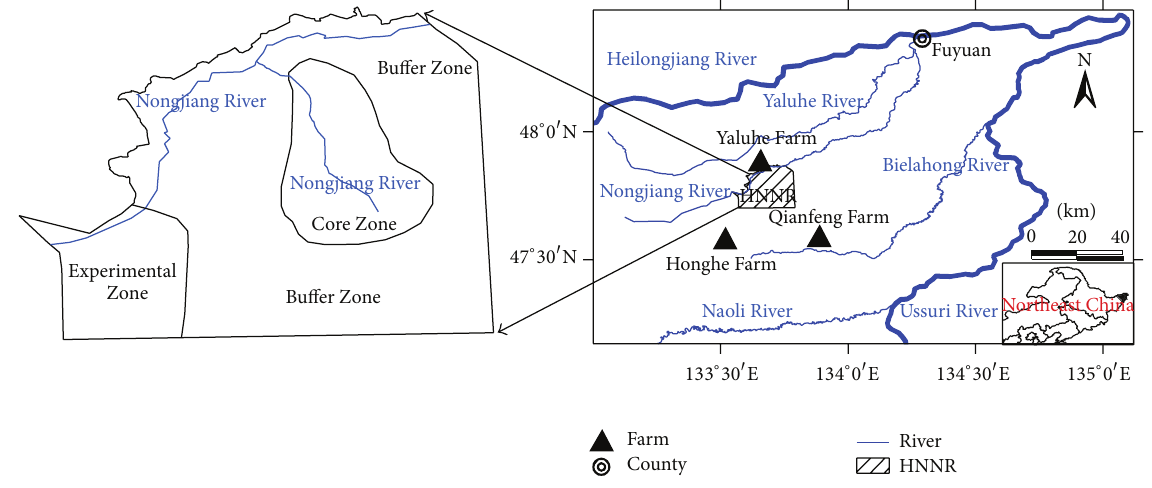
Figure 1: Location of the study